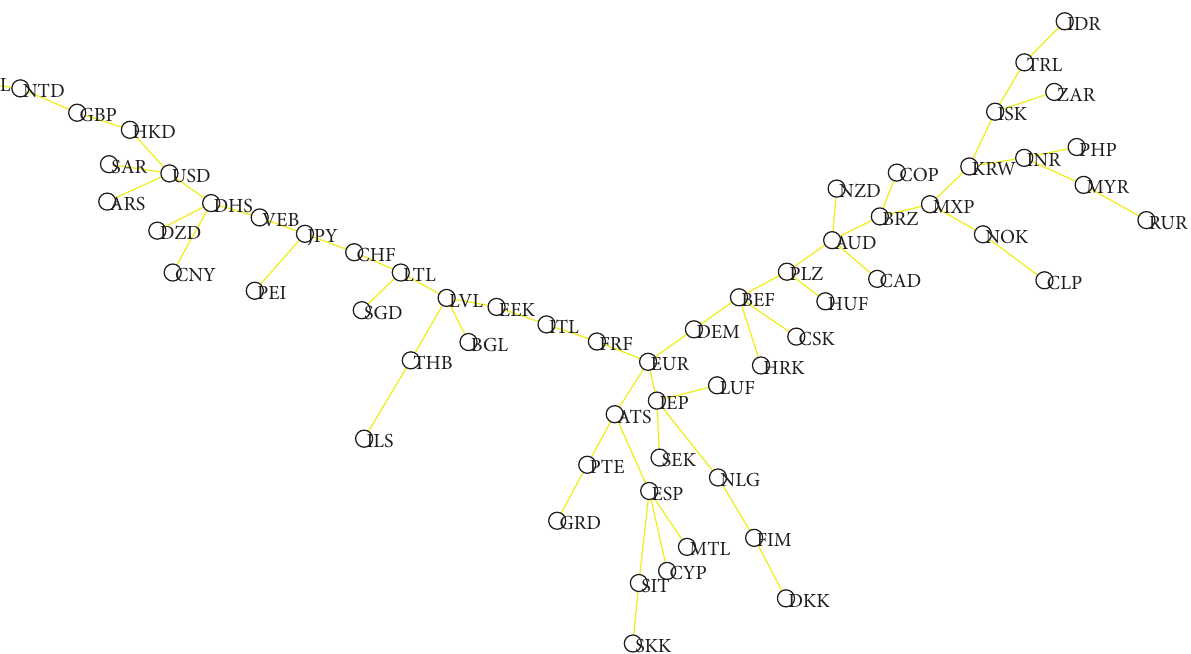
Figure 7: MST of 61 currencies in October 2008, as a representative of the period during US financial crises (window length = 12